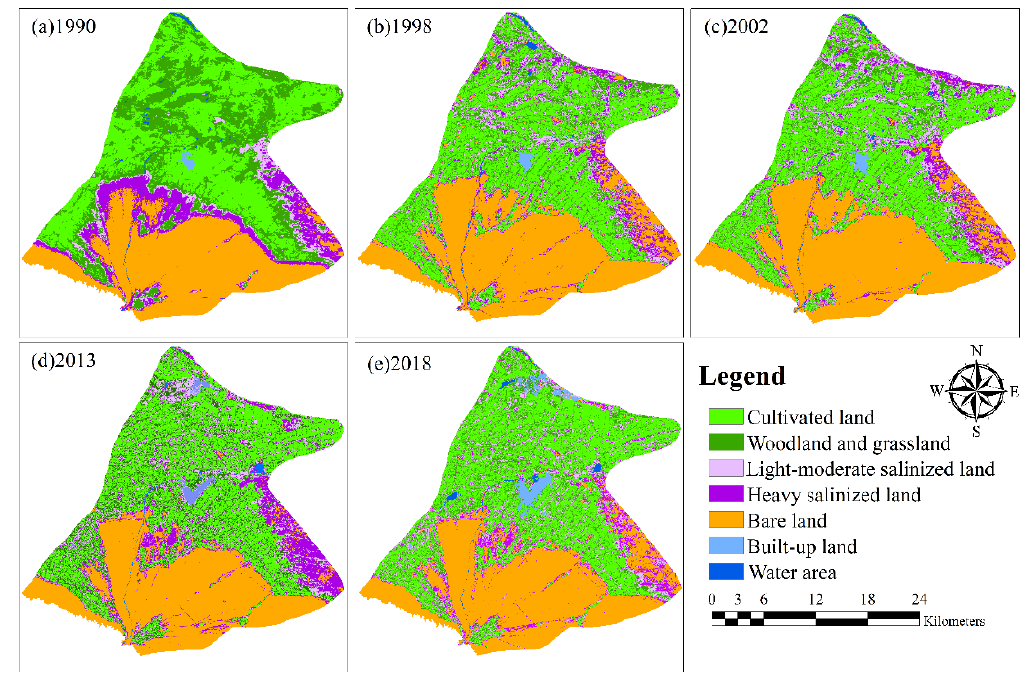
Figure 3. LULC Dynamics (1990–2018) in the arid piedmont plain, Aketao County, China.